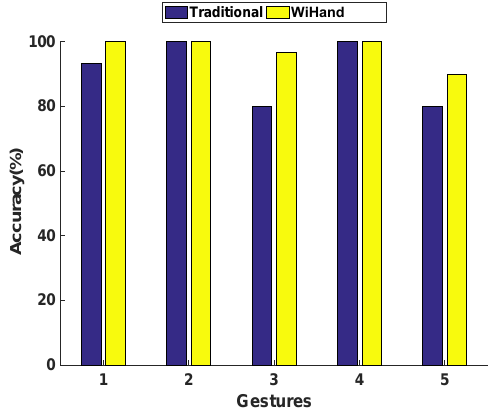
Figure 10. The average accuracy of detection for each gesture.